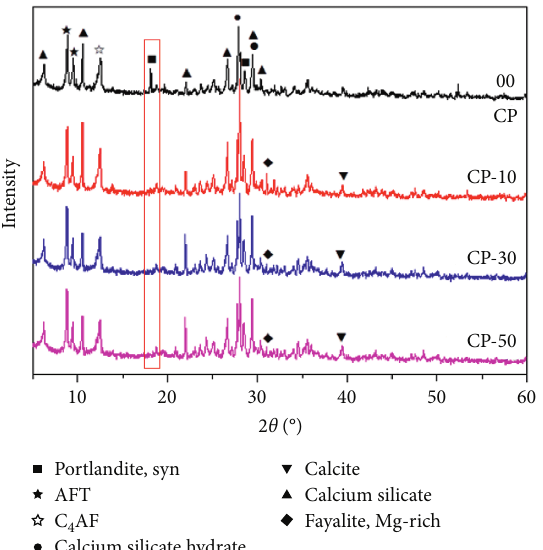
Figure 7: DTG diagrams for cement paste of CP samples cured for 150